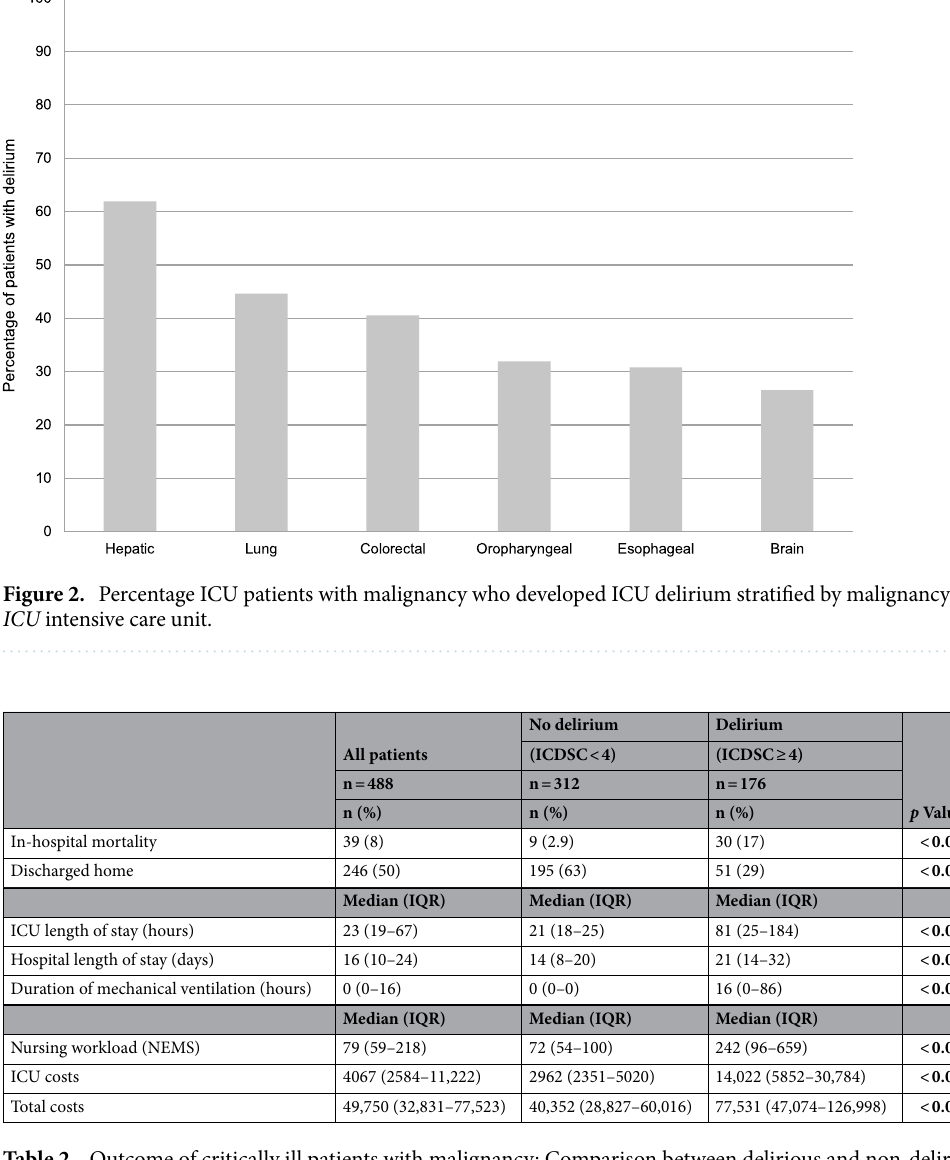
Table 2. Outcome of critically ill patients with malignancy: Comparison between delirious and non-delirious patients. ICDSC intensive care delirium screening checklist, ICU intensive care unit, IQR interquartile range, NEMS nine equivalents of nursing manpower use score. a Comparison of the groups delirium versus no delirium by Fisher’s exact and Mann–Whitney U tests. Bold indicates